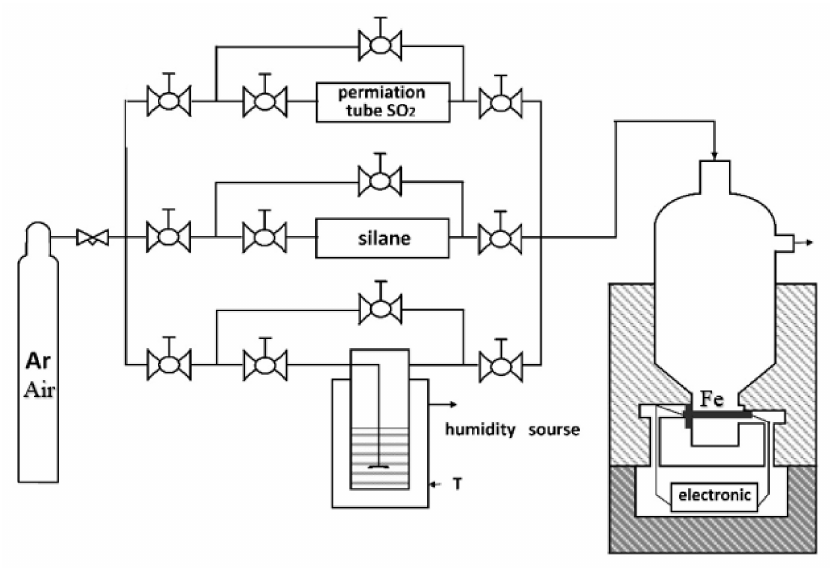
Figure 1. Schematic of the glass system and piezo quartz cell used for silane deposition, measure- ments of water adsorption and iron corrosion [19]. Published with permission from SPRINGER NATURE